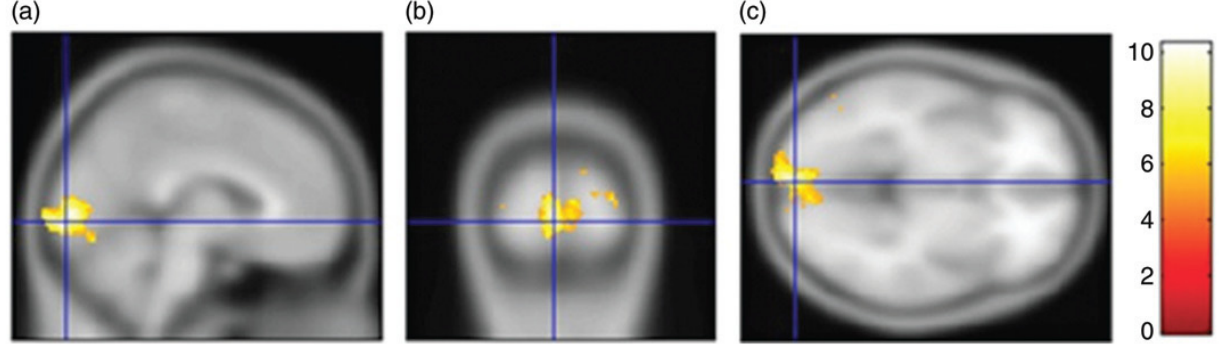
Fig. 2. Brain visual centre activity in a 54-year-old female patient with AMD, VARE: 0.04, VALE: 0.03. Sagittal (a), coronary (b) and transversal section (c) show a significant decrease of the fMRI activity (2 630 voxels, the usual correct threshold P =0.05 with a FWE correction). Both eyes were stimulated simultaneously (ref. 6